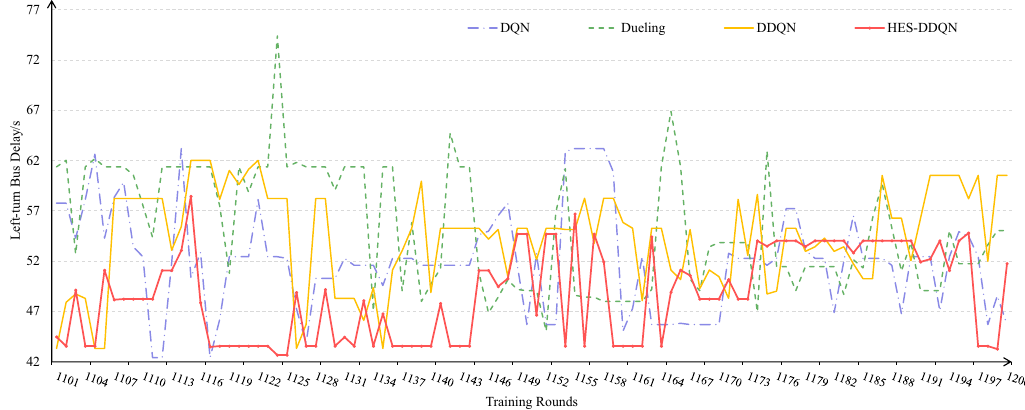
(a) Social Vehicle Queue Length Comparison.